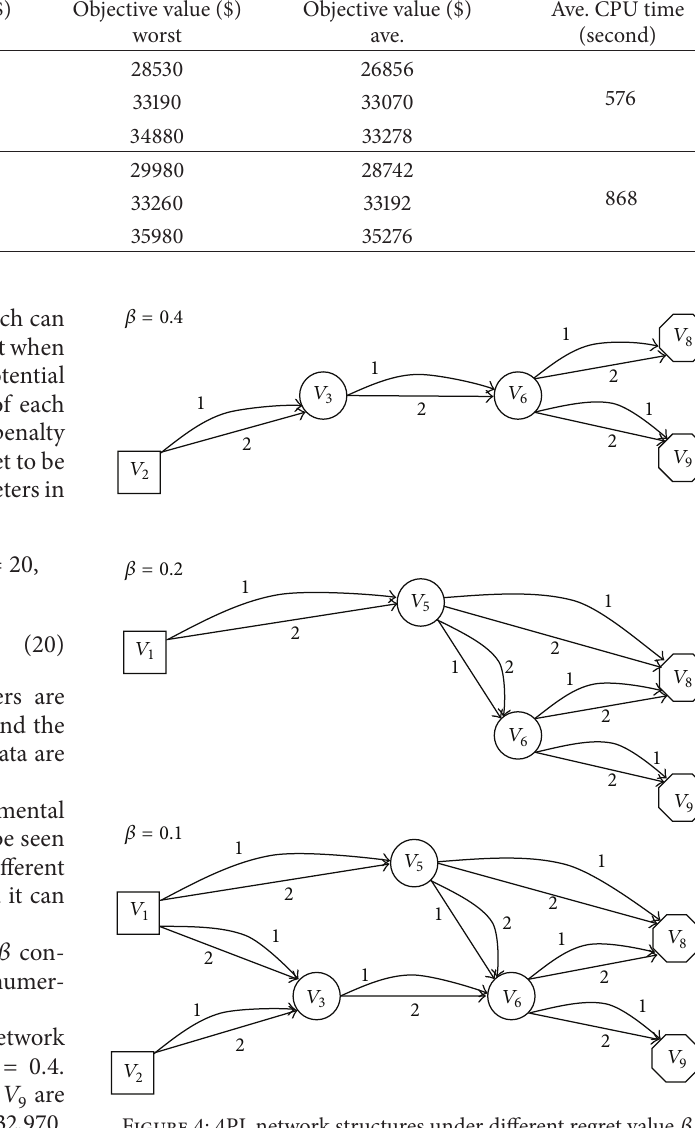
Figure 4: 4PL network structures under different regret value 𝛽